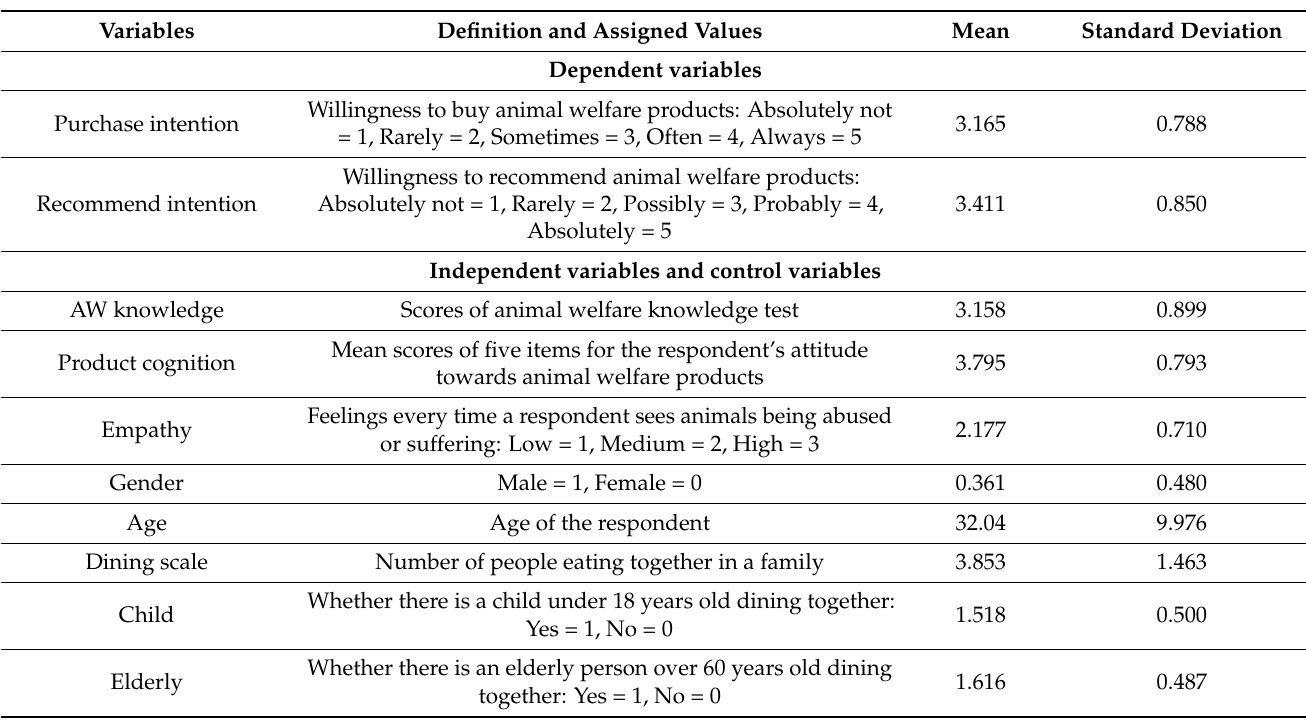
Table 5. Definition and descriptive statistics of each